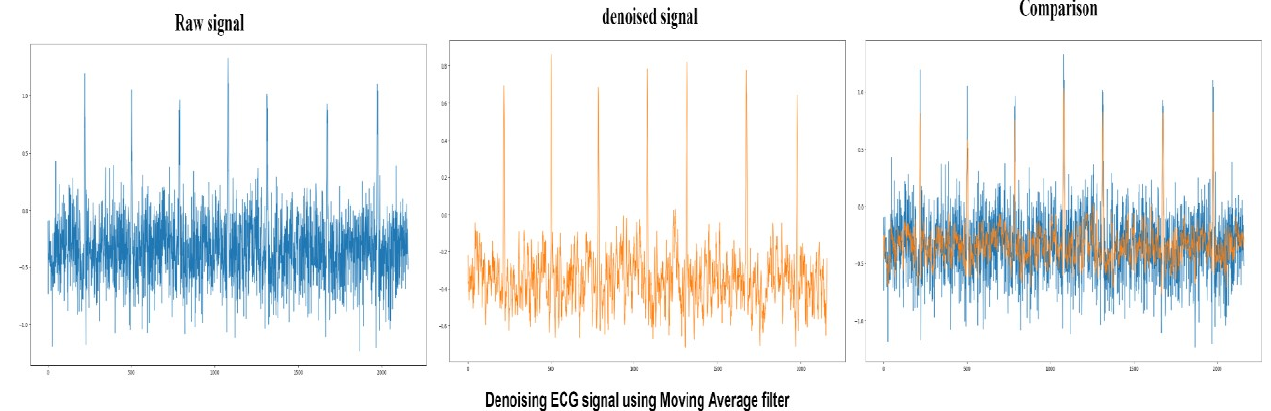
Figure 9. Raw ECG signal (Blue) denoising using Moving average filter and comparison between denoised (Orange) and raw signals.